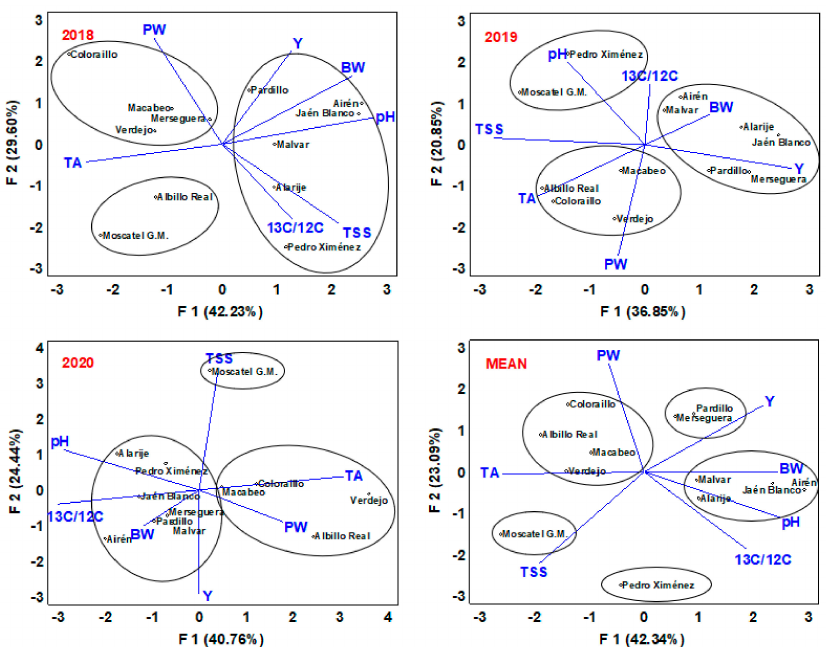
Figure 4. Principal components analysis (PCA) considering the data of each year separately and jointly for the triennium 2018–2020. Y, yield; BW, berry weight; PW, pruning weight; TSS, total soluble solids; TA, total acidity; pH; 13C/12C, carbon isotope